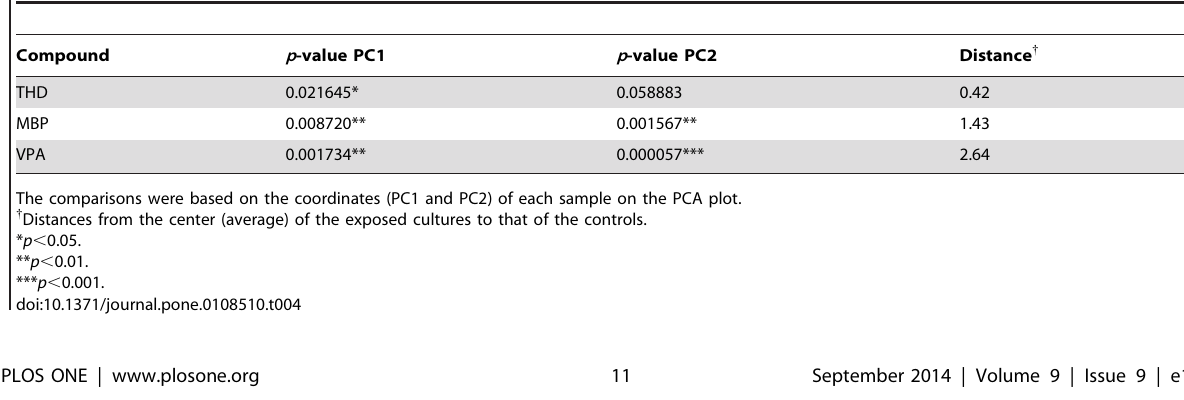
Table 4. Deviation of exposed cultures from the differentiation track based on the 1996 DEGs.